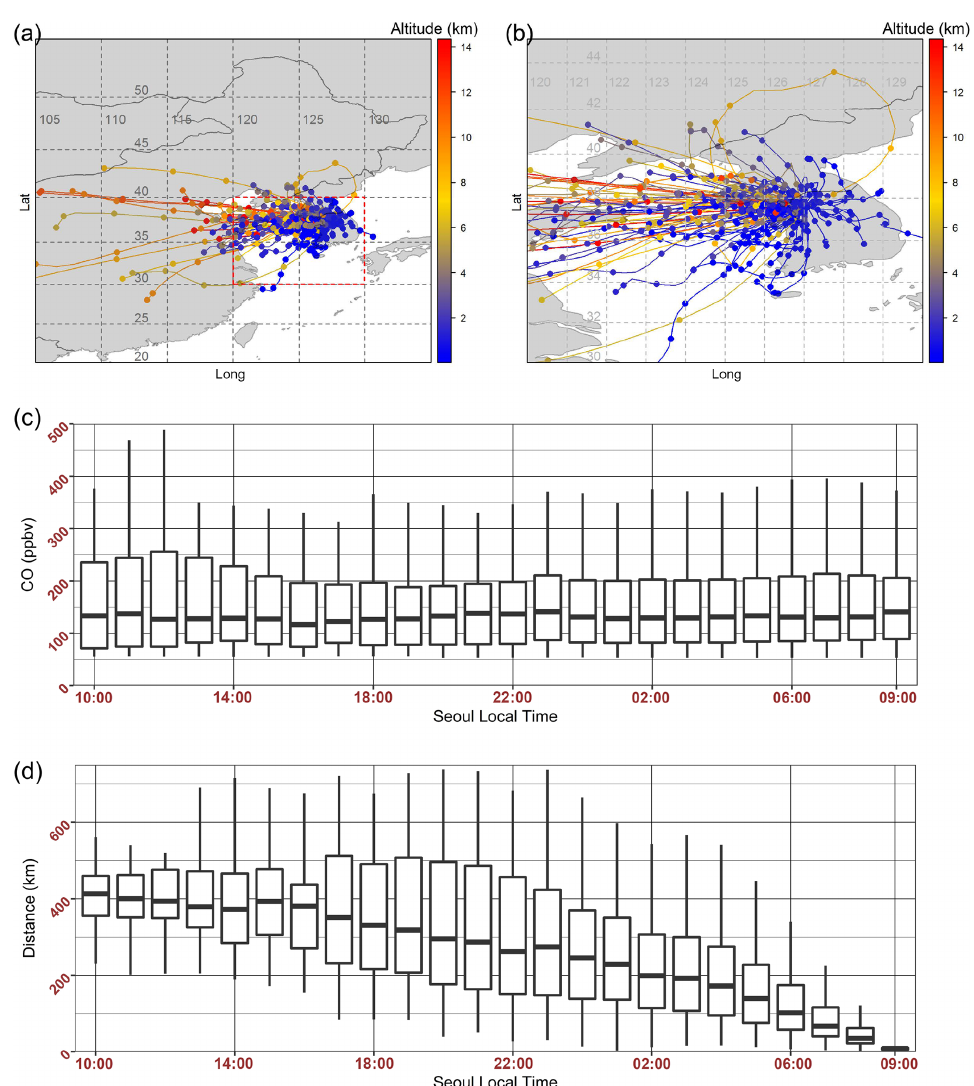
Figure 7. C-TRAIL output for the entire month of May 2016 for Seoul as the receptor: (a) 24h trajectories of packets for the entire domain, (b) 24h trajectories of packets for the zoomed area in South Korea, (c) boxplots of the CO concentrations of all packets at each hour before they reached Seoul, and (d) boxplots of packet distances from Seoul at each hour before the packets reached